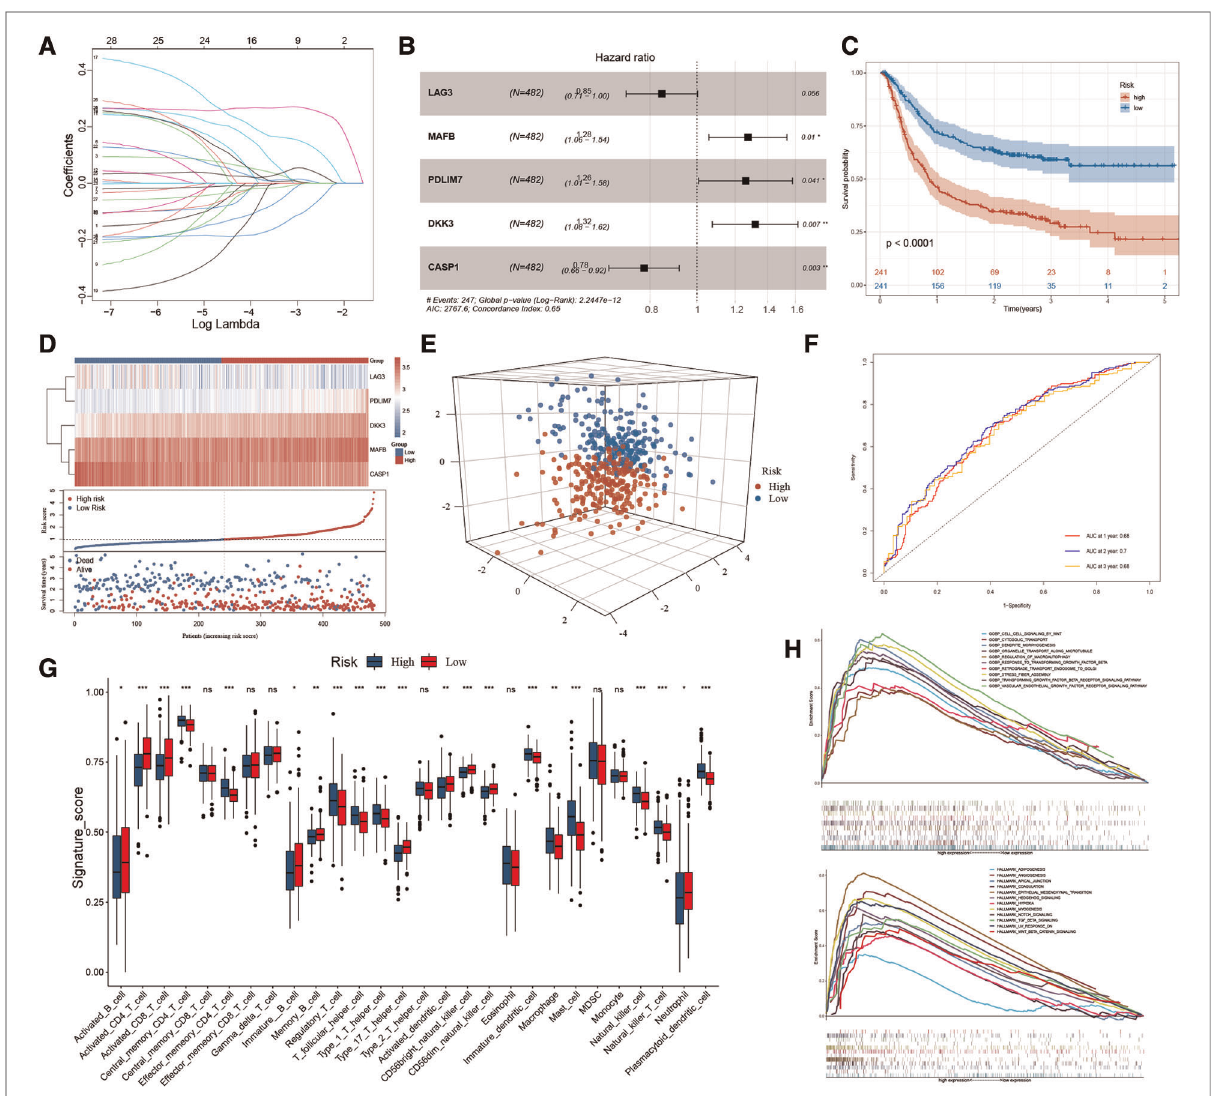
FIGURE 3 The work fl ow of risk-score model construction. ( A ) LASSO model coef fi cients. ( B ) * P <0.05 in multivariable Cox proportional hazards model. ( C ) Kaplan-Meier survival curve of the OS in the high- and low-risk groups (meta-dataset). ( D ) From top to bottom are fi ve prognostic signature RNAs expression heatmap, the risk score, and patients ’ survival status distribution between low- and high-risk groups. ( E ) Principal component analysis (PCA) shows the difference between the high-risk and low-risk groups based on the risk score. ( F ) ROC curves for 1-year, 2-year and 3-year overall survival, with AUC=0.68 , 0.70 and 0.66 respectively. ( G ) The box plot results suggest that tumor-in fi ltrating immune cells were signi fi cantly differently distributed in the high-risk and low-risk groups. ( H ) GSEA results show the relevant signaling pathways involved in the high-risk